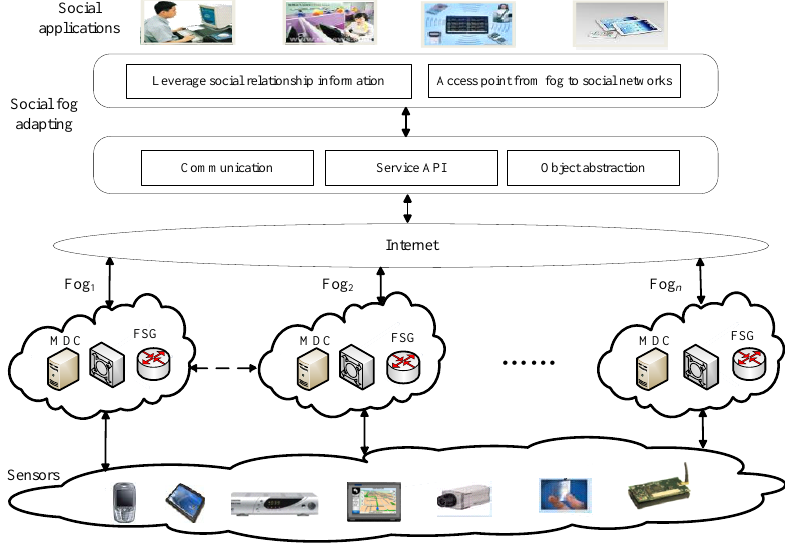
Figure 1. Service scenario of social fog.